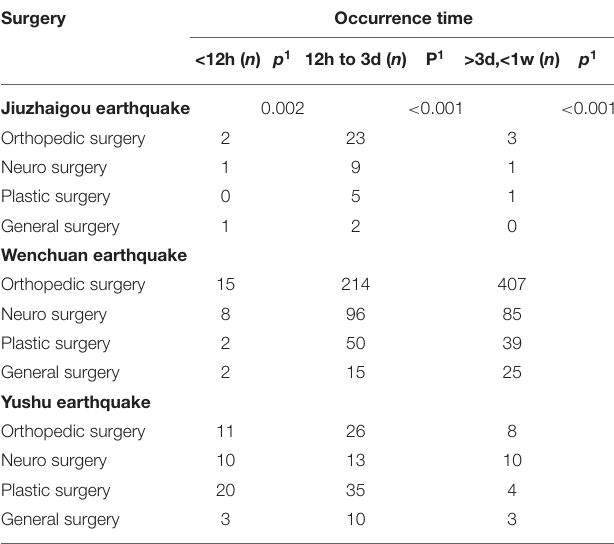
TABLE 5 | The time of the different surgical treatment in Jiuzhaigou, Whenchuan and Yushu earthquake patients. Surgery Occurrence